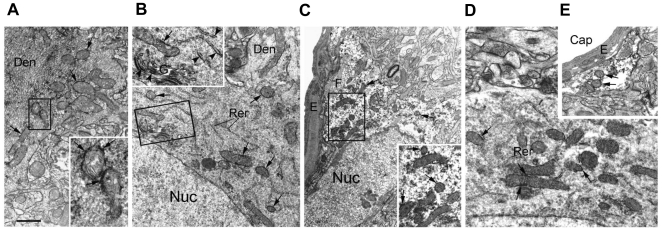
EAAC1 Pre-embedding Immunoelectron Microscopy.(A–E) Specific staining (granular electron-dense reaction product) is present on the membrane of some mitochondria (arrows) contained into the dendrites (a,b), neuronal somata (b,d) and astrocyte soma (c) and perivascular processes (e) of both rat cerebral cortex (a–c) and hippocampus (d,e). Labeling is also scattered in the cytoplasm and present into cisterns of the rough endoplasmic reticulum and Golgi apparatus (arrowheads, inset of b). Insets are the enlargement of the corresponding framed area. Den, dendrite; Nuc, nucleus; G, Golgi apparatus; RER, rough endoplasmic reticulum; E, endothelium; F, filaments; Cap, capillary. Bar: a, 3 µm; b, 4 µm; c, 6 µm; d, 1.5 µm; e 2.5 µm; inset of a, 1 µm; inset of b, 2 µm; inset of c, 2.5 µm.